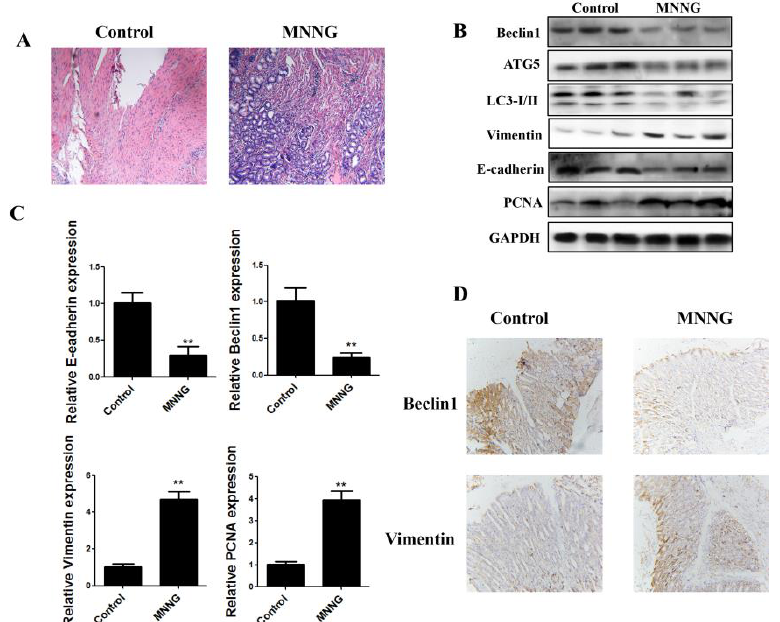
Figure 1. Long-term MNNG exposure induced EMT, proliferation, and inhibited autophagy in gastric tissues of rats. Rats were exposed to MNNG (100 mg/kg BW) every 5 days for 12 weeks: ( A ) hematoxylin and eosin-stained sections of gastric tissues after long-term MNNG exposure. Tissues from 3 rats were examined; the representative image is shown; ( B ) MNNG-induced alterations in the protein expression of autophagy, EMT and proliferation markers. Tissues from n = 3 rats as representative images; ( C ) MNNG reduced mRNA levels of autophagy and epithelial markers and increased the mesenchymal and proliferation markers. Real-time PCR results are these samples from 3 rats, and the experiments were repeated three times: ( D ) immunohistochemistry showing decreased Beclin1 expression and increased vimentin. Tissues from 3 rats were examined; the representative image is shown. GAPDH served as the housekeeping gene; ** p < 0.01, compared with control